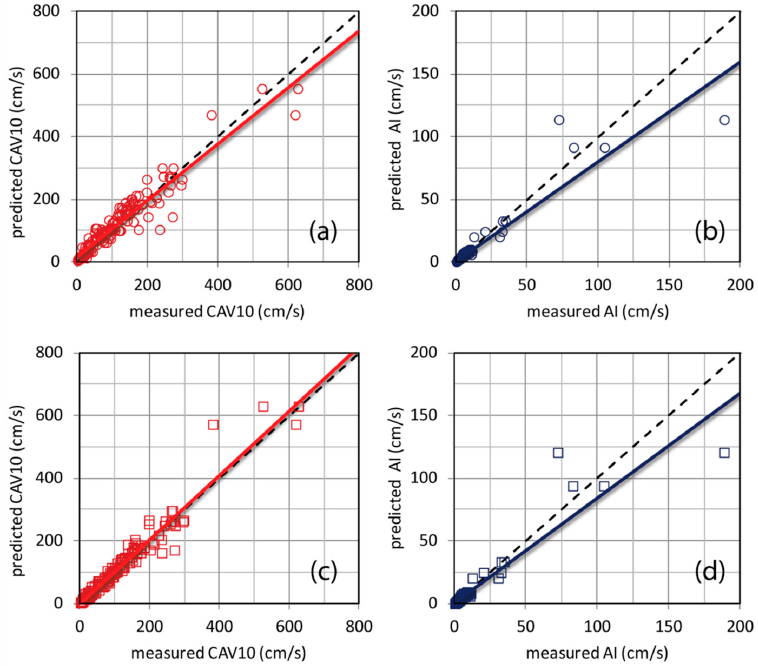
Figure 4. Cross-validation between measured and predicted values through kriging ( a , b ) and cokriging ( c , d ) methods with the exponential fitting model for the M W 6.0 Amatrice earthquake. For the cokriging method, CAV10 and AI were selected alternatively as primary and the other one with PGA and PGV as secondary variables.